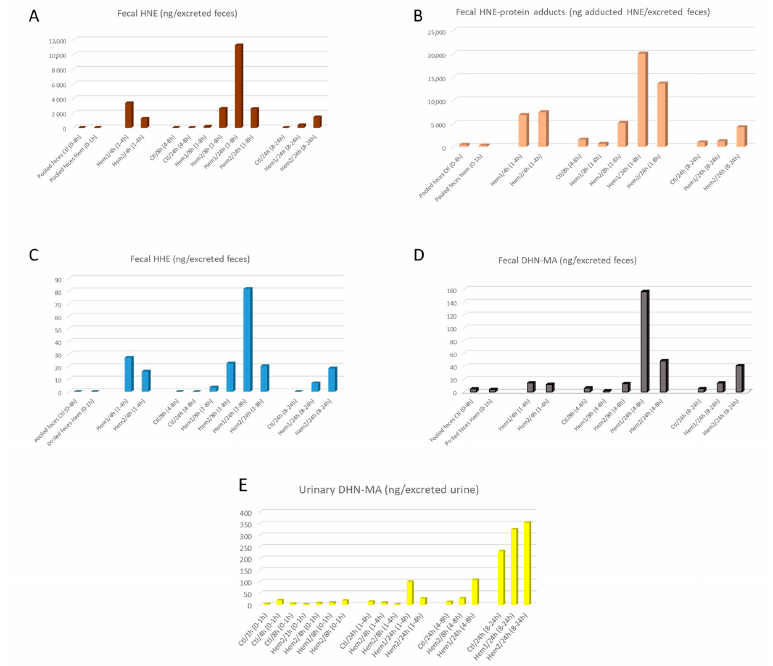
Figure 2. Excretion of fecal HNE, 4-hydroxyhexenal (HHE) and HNE metabolites in feces and urine after oral gavage of safflower oil +/ − hemin. ( A ) fecal HNE; ( B ) fecal HNE-protein; ( C ) fecal HHE; ( D ) fecal 1,4-dihydroxynonane-mercapturic acid (DHN-MA); ( E ) Urinary DHN-MA. Samples are identified as “treatment/time of sacrifice (sampling period)” with Treatment = “Ctl”, “Hem1” or “Hem2”; time of sacrifice = 1, 4, 8 or 24 h; feces from different animals were pooled when samples were too small: Ctl feces from 0 to 4 h and Hem feces from 0 to 1 h. For each time point, 3 animals were sacrificed: Ctl had received only safflower oil at the starting time point (T0), while Hem1 and Hem2 had received a mixture of safflower oil + hemin at T0. Each bar represents the excretion of one animal, except when indicated “pooled feces”.